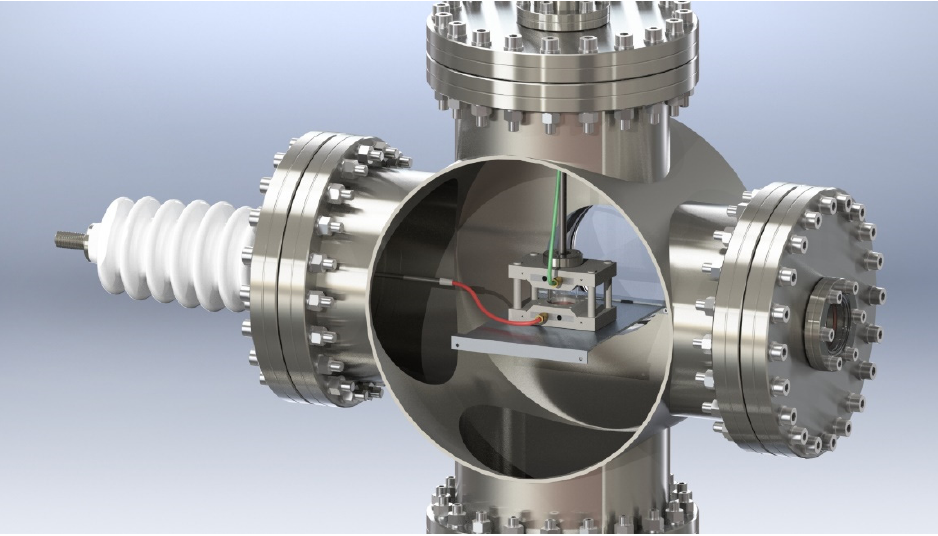
Figure 4. Rendering of the sample holder in the vacuum chamber, fixed to the PEEK gripping structure, the electrodes connected to the sample holder, and the feedthrough on the left. The bottom electrode is connected to the high voltage supply, whereas the top electrode is grounded (connected to the vacuum chamber). However, the electrode connectors can be inverted because the top electrode is insulated from the SS connection of the linear